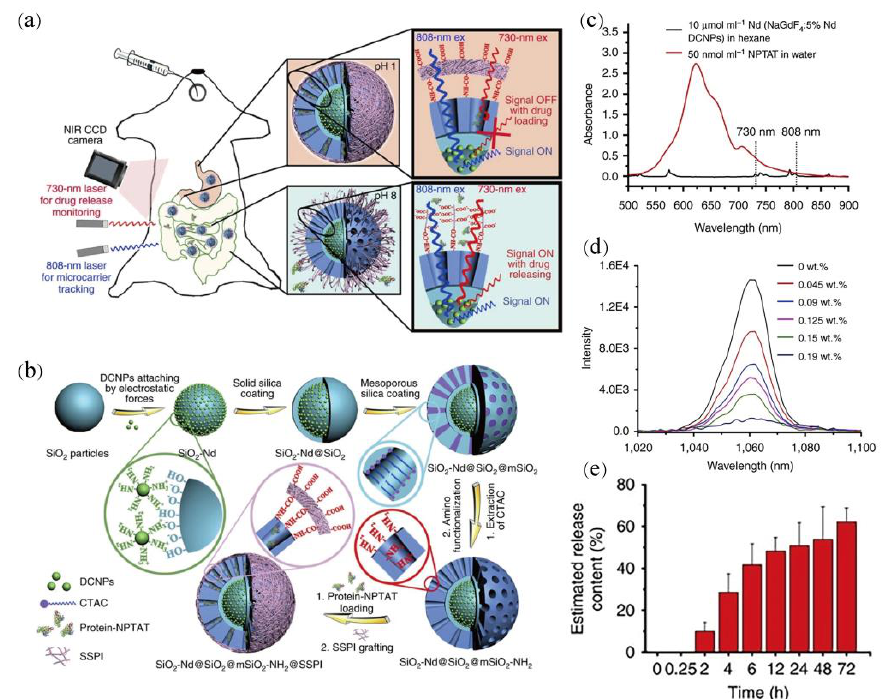
Figure 11. ( a ) Schematic of in vivo mSiO 2 −Nd tracking and drug release monitoring by NIR−II emis- sion. ( b ) Experimental processes of designing the NIR−II mesoporous microcarriers. ( c ) Absorption emission. ( b ) Experimental processes of designing the NIR − II mesoporous microcarriers. ( c ) spectra of LnNCs dispersed in hexane and NPTAT dispersed in water. ( d ) NIR−II signals, as a fun c-